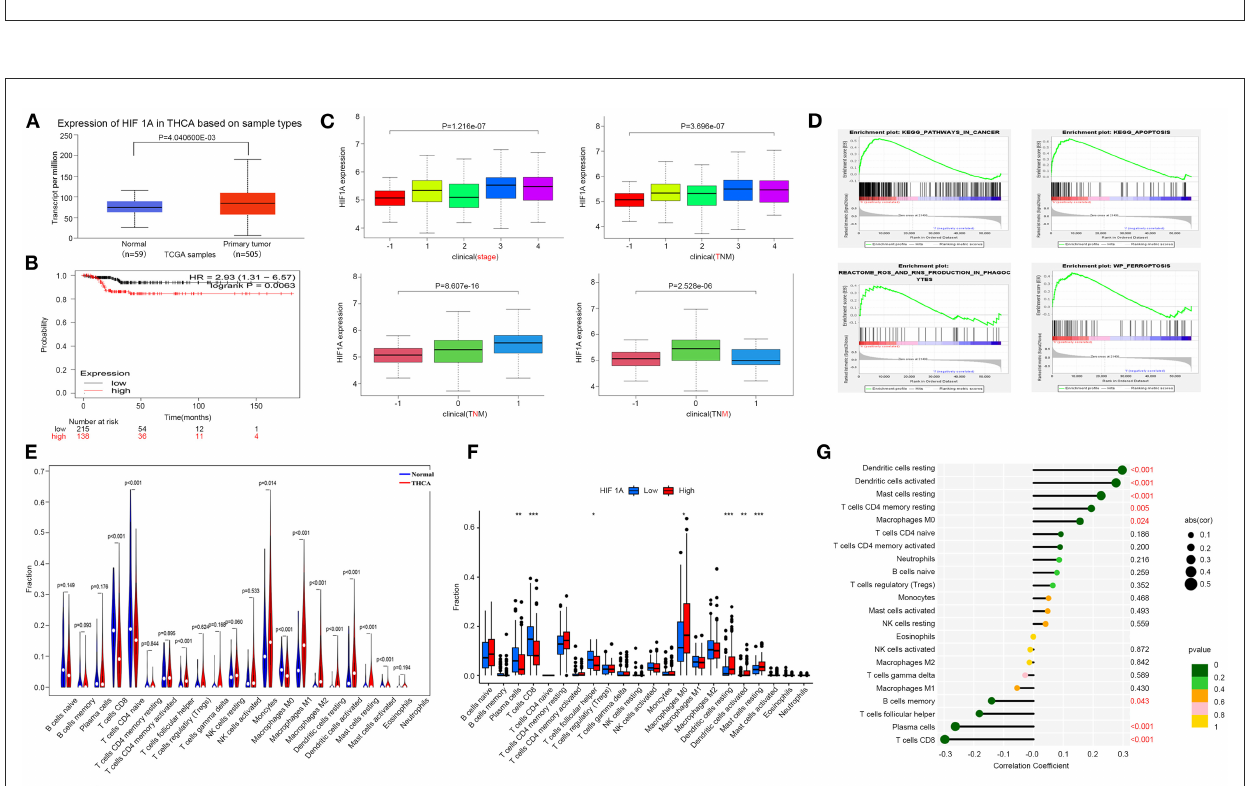
FIGURE4 PPI network and cytoscape to obtain hub genes. (A, B) F-DEGs were analyzed with a PPI network and visualized with Cytoscape. (C) Hub network construction of HIF1A, ATM, MAPK14, TLR4, HSPA5, MAPK8, and CREB1.